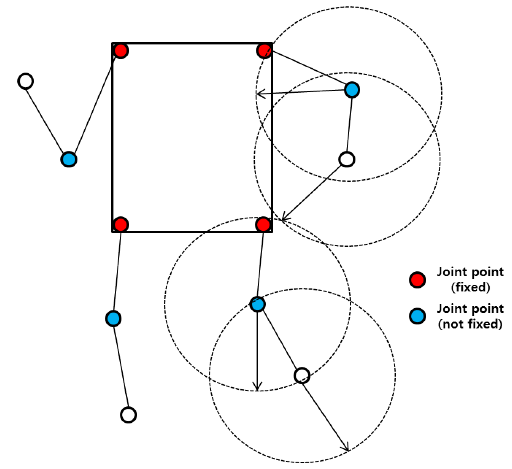
Figure 11. An example of the walking